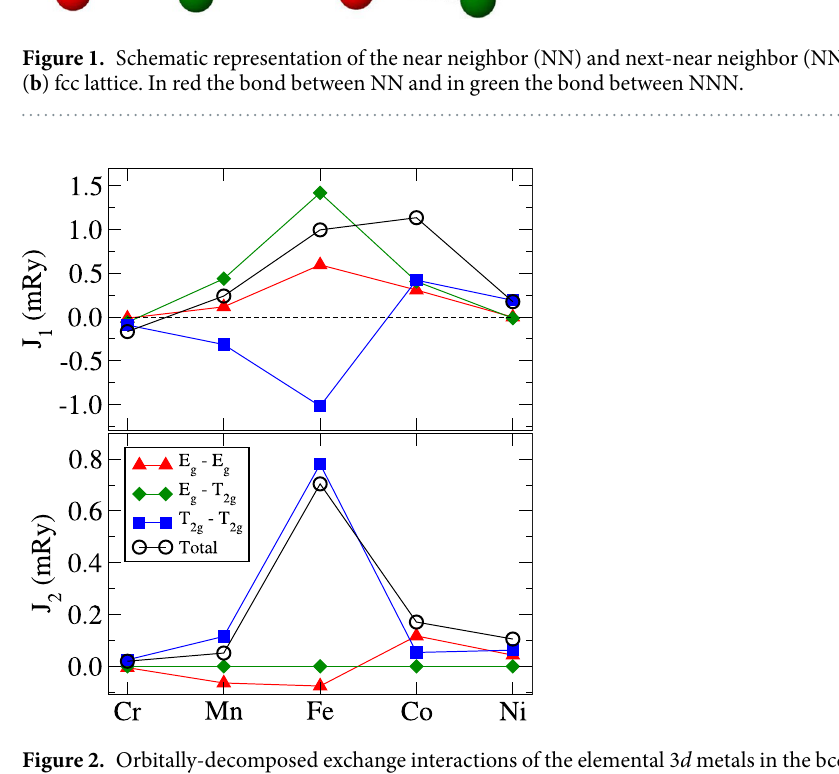
Figure 2. Orbitally-decomposed exchange interactions of the elemental 3 d metals in the bcc structure. Top panel: NN coupling J 1 . Bottom panel: next NN coupling J 2 . The top panel is the same as Fig. 1 from ref. 19 , except for Cr, which was here studied for a lattice constant of 5.46 a.u., whereas a = 5.67 a.u. was used in ref. 19 . The results for both volumes are reported in the